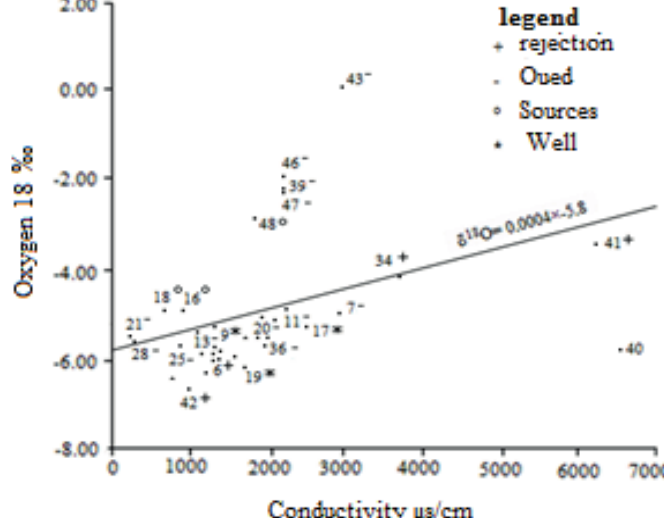
Fig. 5 The Oxygen 18–conductivity